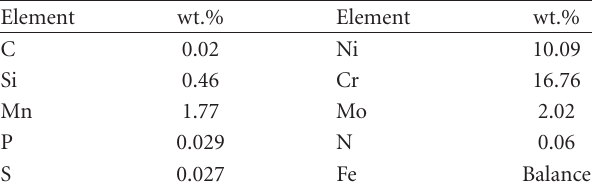
Table 1: Chemical composition of as-received 316L stainless